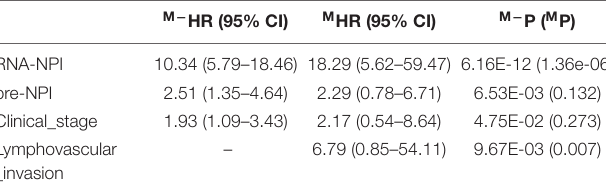
TABLE 3 | MCA of RNA-NPI, pre-NPI, and clinicopathological